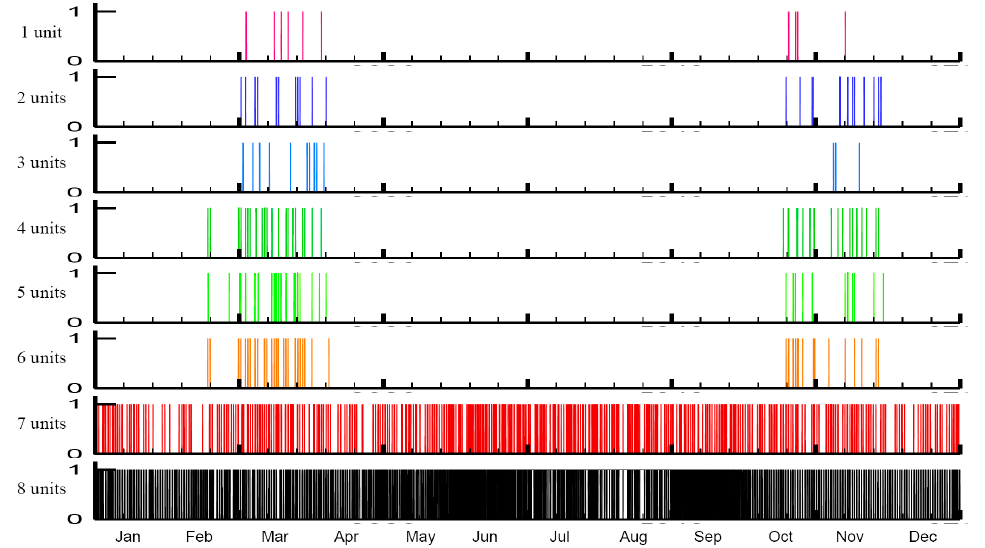
Figure 7. Occurrence distribution of number of active RO units in the DeReC system during a reference year. a reference